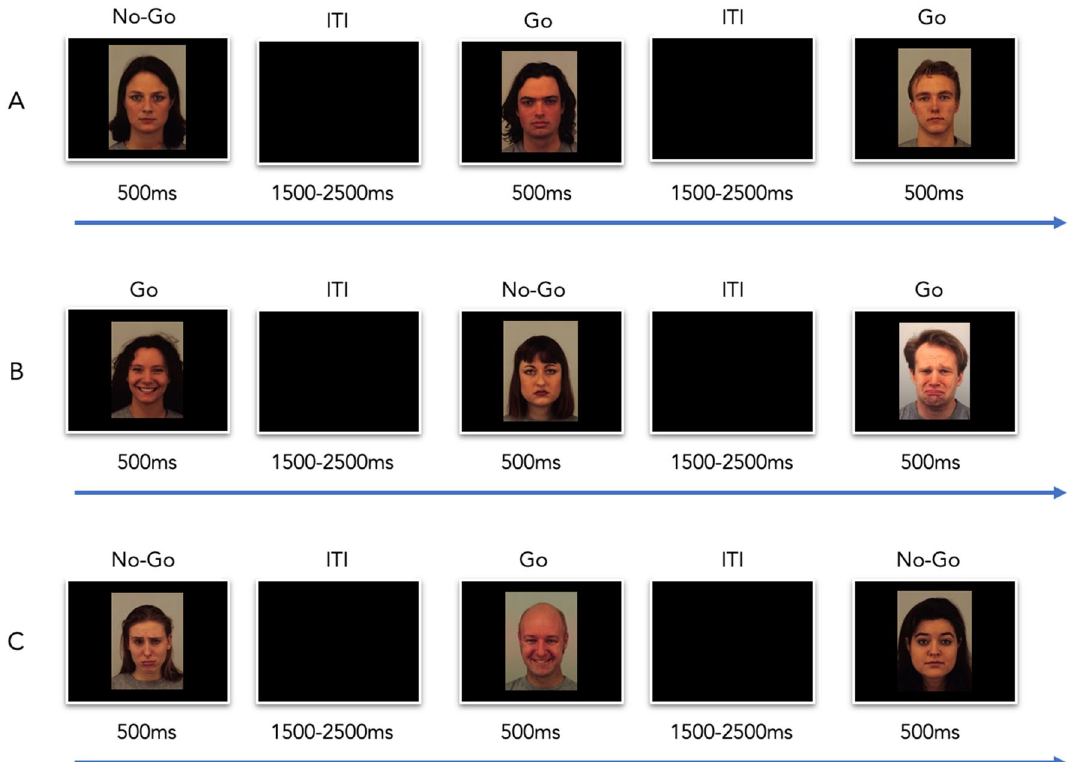
Figure 4. Examples of trials of the 3 GNG task variations. ( a ) NE variation: participants should respond to male faces and withhold response to female faces. All faces are with neutral expressions; ( b ) EE variation: participants should respond to emotional faces (happy or sad expressions) and withhold response to neutral facial expressions; ( c ) IE task variation: participants should respond to male faces and withhold response to female faces (regardless of the facial expression, which can be happy, sad or